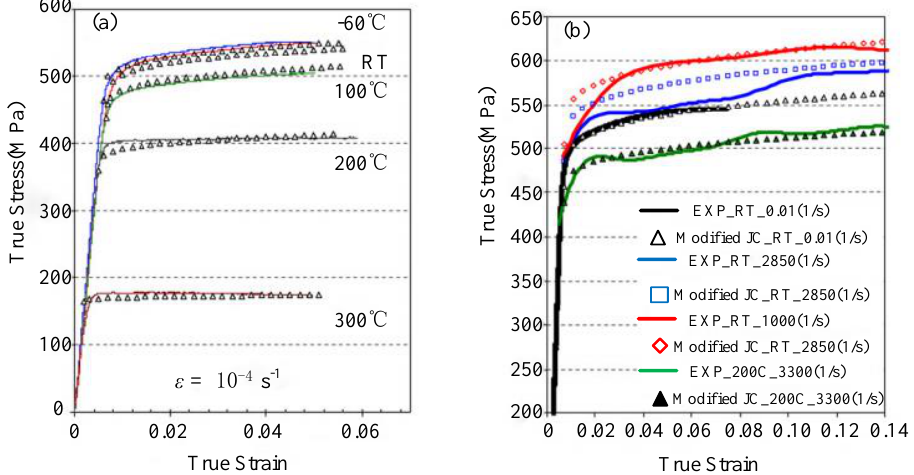
Figure 3. Vural and Caro modified J – C model [15], ( a ) temperature dependence of flow stress at 10 − 4 s −1 reference strain rate; ( b ) effects of strain rate and temperature under dynamic